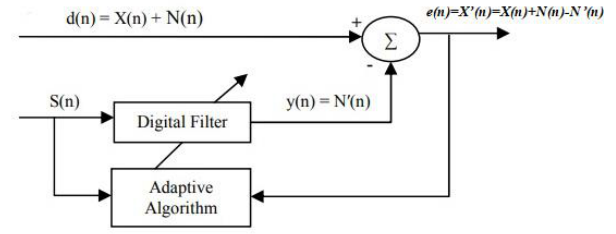
Figure 1. Principle of the adaptive filter in noise cancellation. Least mean squares (LMS), Normalised Least Mean Squares (NLMS), and Recursive Least Squares (RLS) are the three most commonly used algorithms in adaptive filtering.